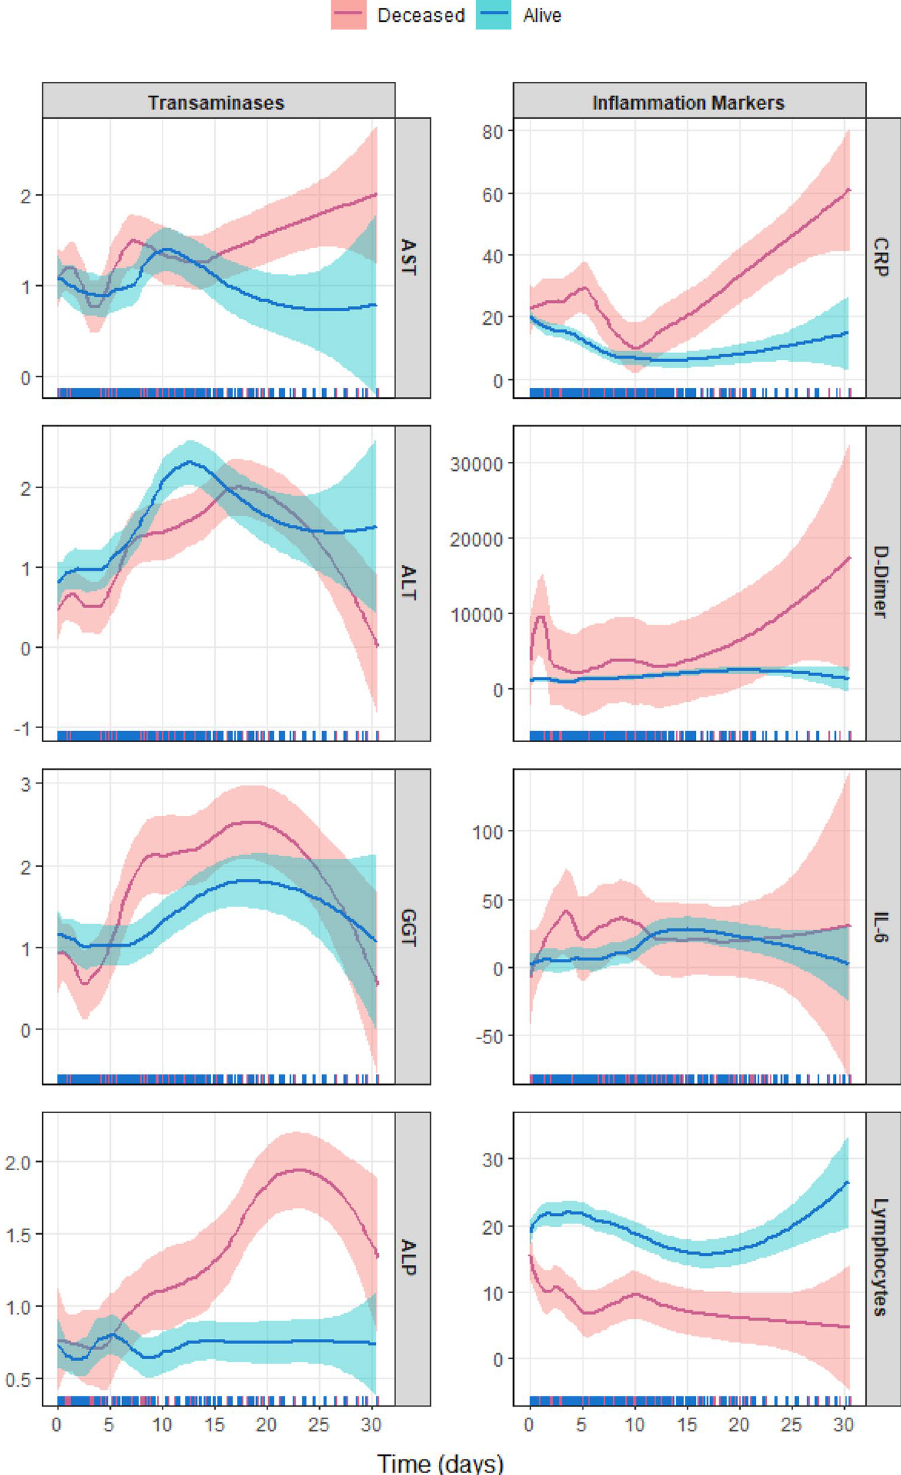
Figure 1. Exploratory curves for weighted values (when necessary) of transaminases (left) and inflammation markers (right) over time for deceased (pink) and living (blue) patients, along with 95% confidence intervals. Estimation made using a lasso regression